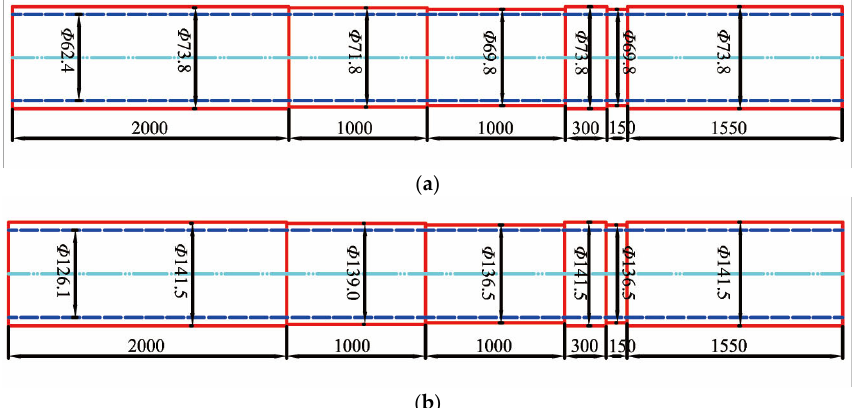
Figure 4. Specimens for tubing and casing inspection: ( a ) Corroded tubing; ( b ) Corroded casing.